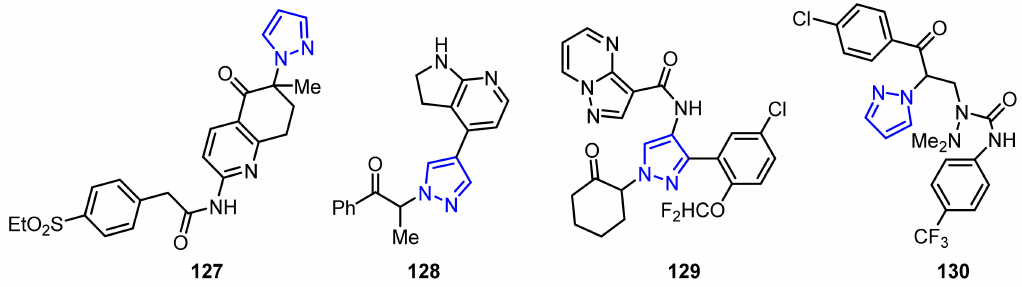
Figure 6. Applications of α -pyrazole ketone scaffolds in bioactive